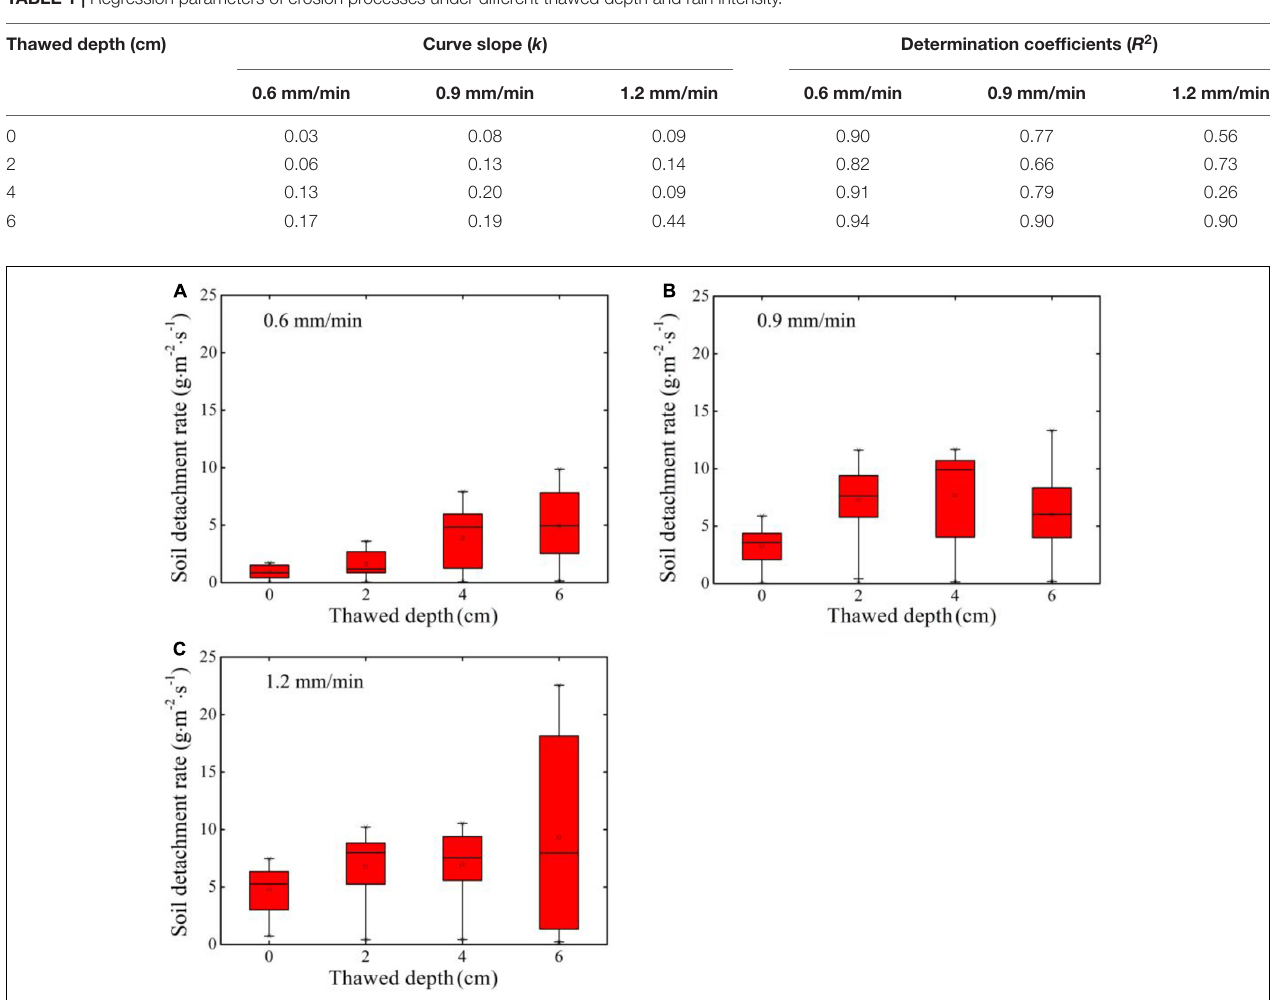
FIGURE 3 | The box plot of soil loss rate under different thawed depth at 0.6 mm/min (A) , 0.9 mm/min (B) , and 1.2 mm/min (C)